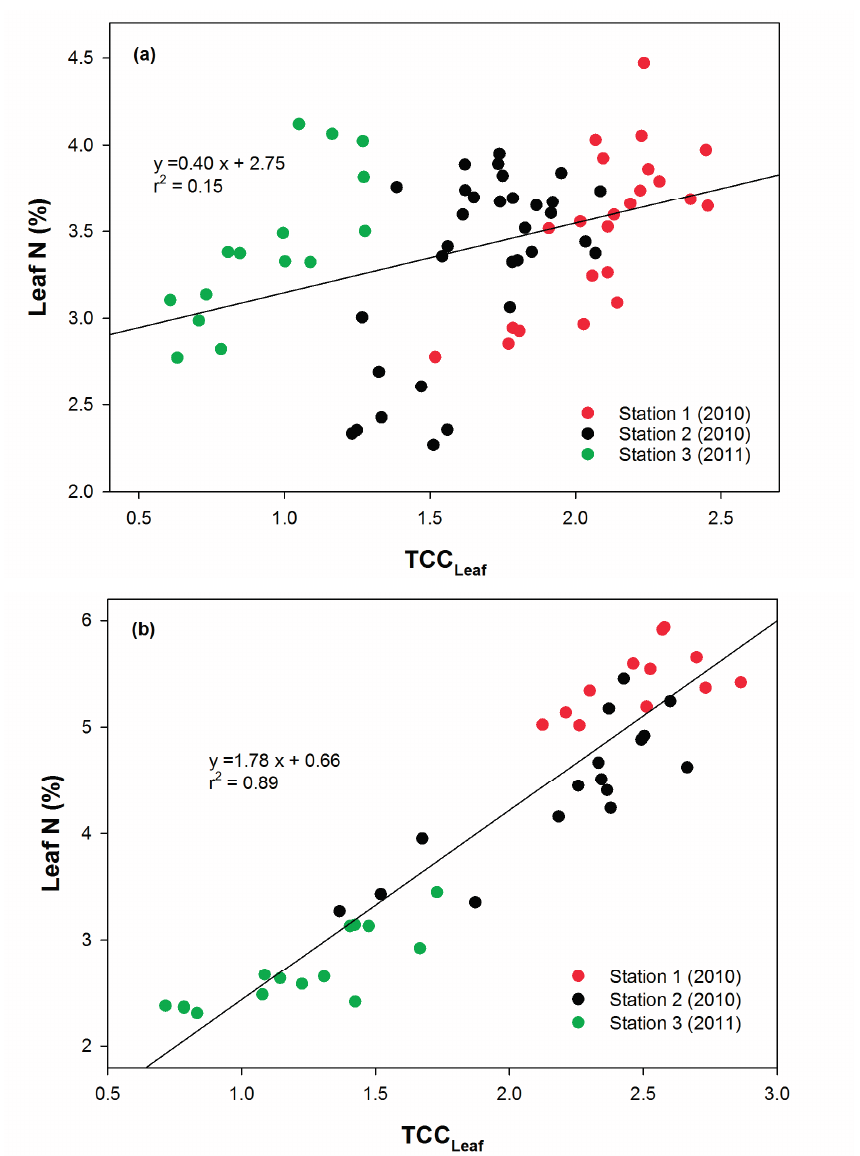
Figure 3. Linear regression between TCC Leaf and leaf N at ( a ) mid to late squaring, and ( b ) early